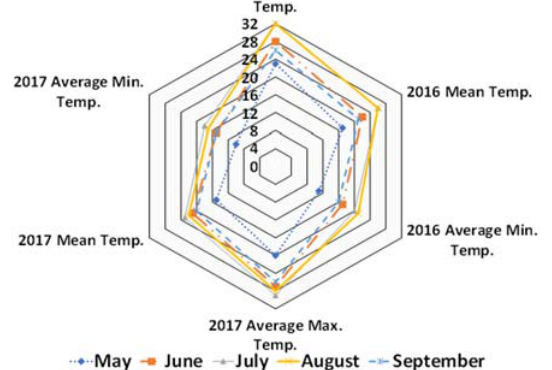
Figure 3. Comparison of the averages of maximum, minimum, and mean temperatures for the outdoor weather conditions during the warmest months between 2016 and 2017.